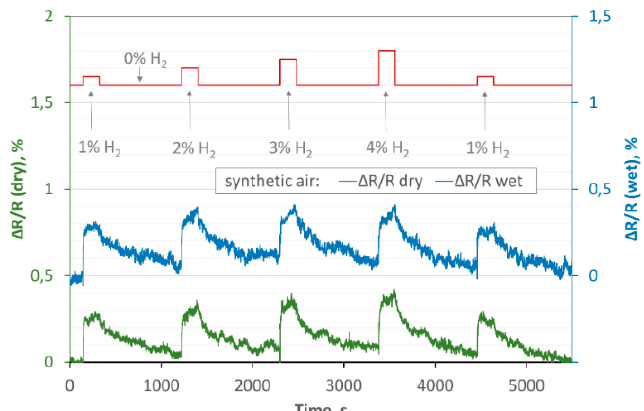
Figure 9. ∆ R / R calculated for dry and wet synthetic air vs. time, temperature: 150 ◦ C, concentration of Figure 9. Δ R/R calculated for dry and wet synthetic air vs. time, temperature: 150 °C, concentration hydrogen in synthetic air, Sample 2. of hydrogen in synthetic air, Sample 2.